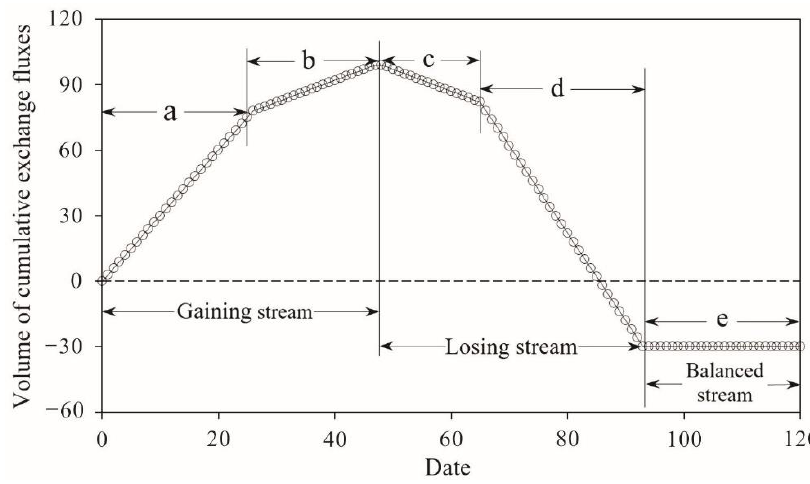
Figure 1. Schematic diagram of the results of cumulative exchange fluxes.